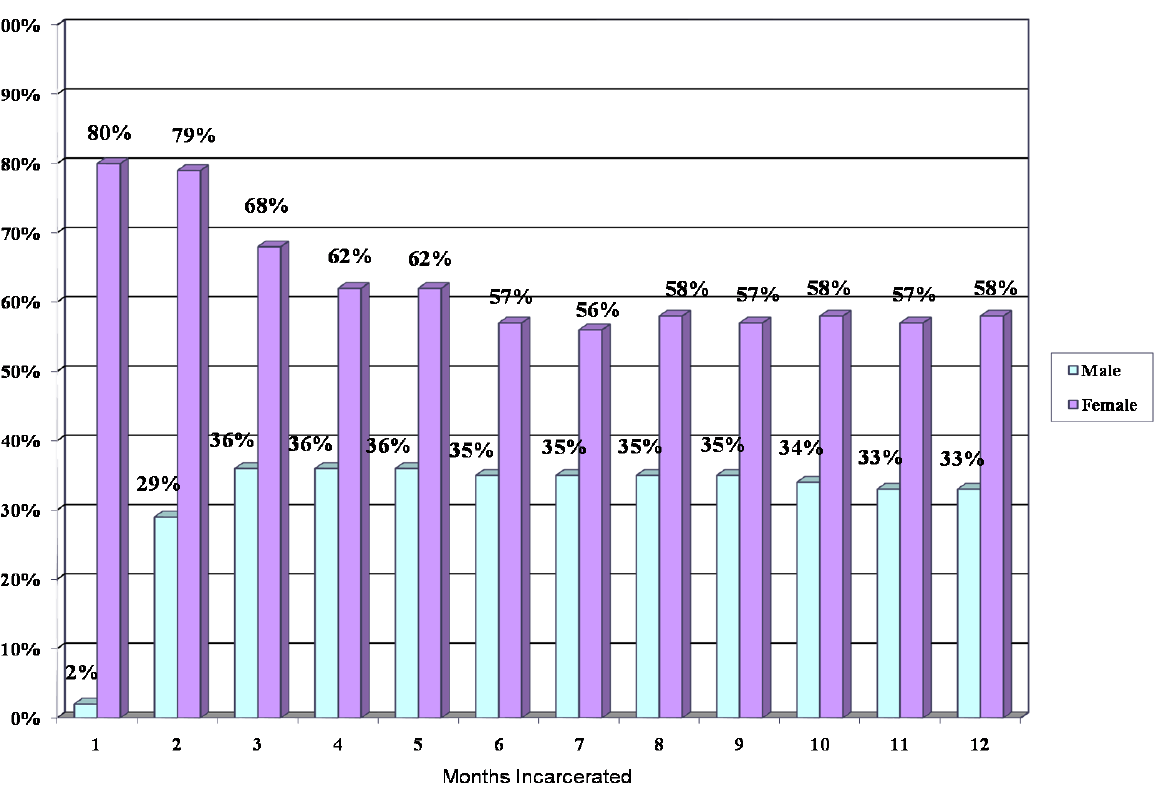
Figure 4. Average Attendance for Male (N = 3009) and Female (N = 349) Across Months of